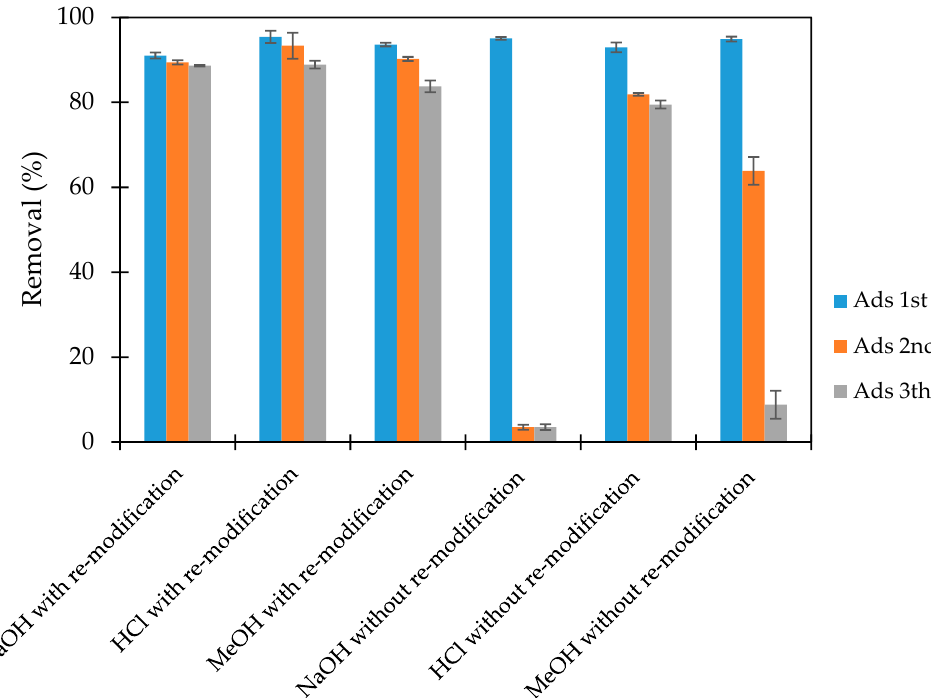
Figure 9. Regeneration of adsorbent with remodification and without remodification using different solutions NaOH, HCl, MeOH. Error bars show standard deviation of three replicates.